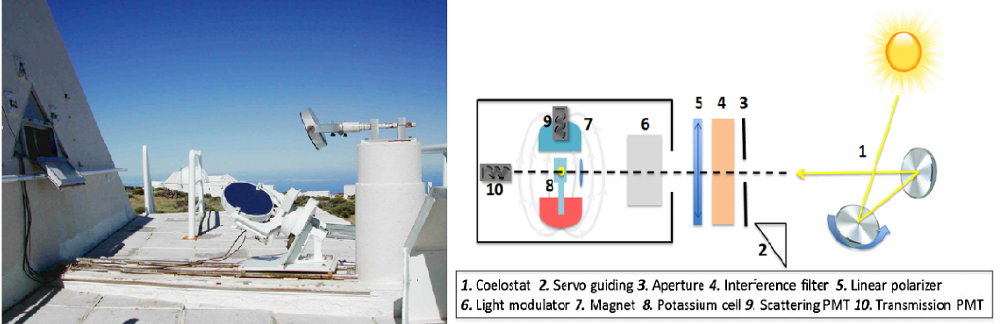
Figure 1. The (a) Mark-I coelostat system at the entrance of the spectrometer; and (b) and diagram of the main constituents of the Mark-I spectrometer. PMT is photomultiplier